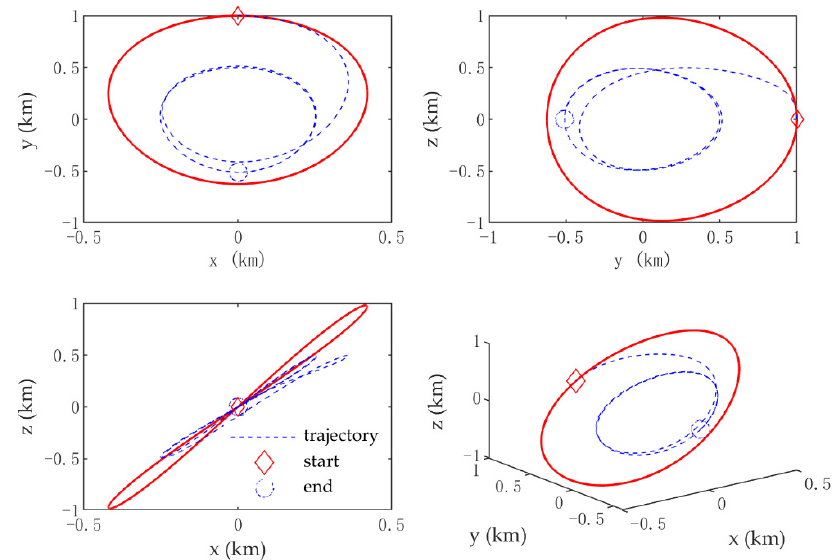
Figure 9. Trajectories of relative transfer orbit and formation for the case without in-track control. Table 5. Performance